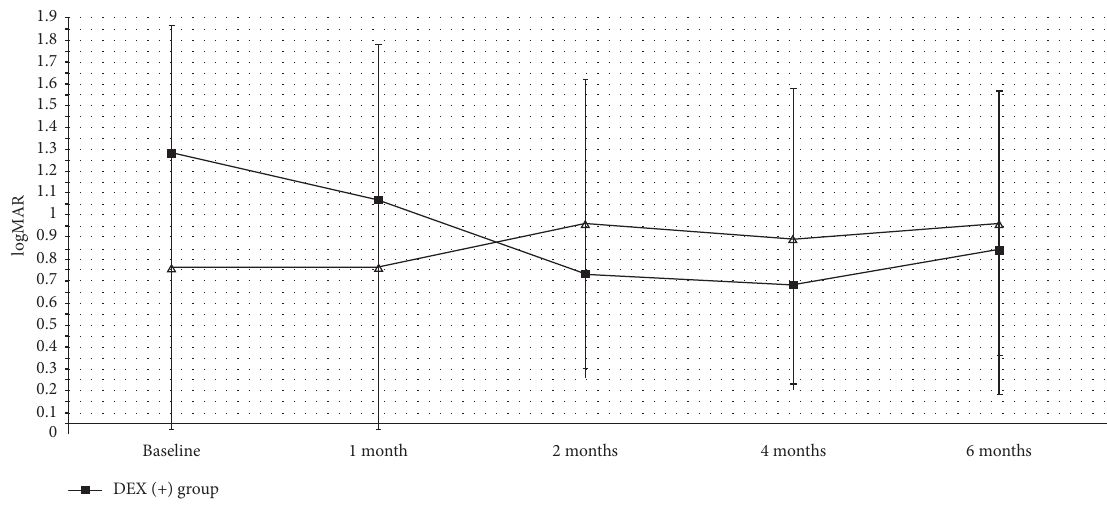
Figure 5: Best-corrected visual acuity (BCVA) change for the DEX (+) group and DEX ( − ) group. The BCVA at the baseline and 1, 2, 4, and 6 months during the follow-up period is shown in this figure. The change of BCVA for the DEX (+) group was defined with a line chart with solid square, while the change of BCVA for the DEX ( − ) group was defined with a line chart with open arrowhead ( ∗ P < 0 . 5, ∗∗ P < 0 . 1, and ∗∗∗ P < 0 . 01).